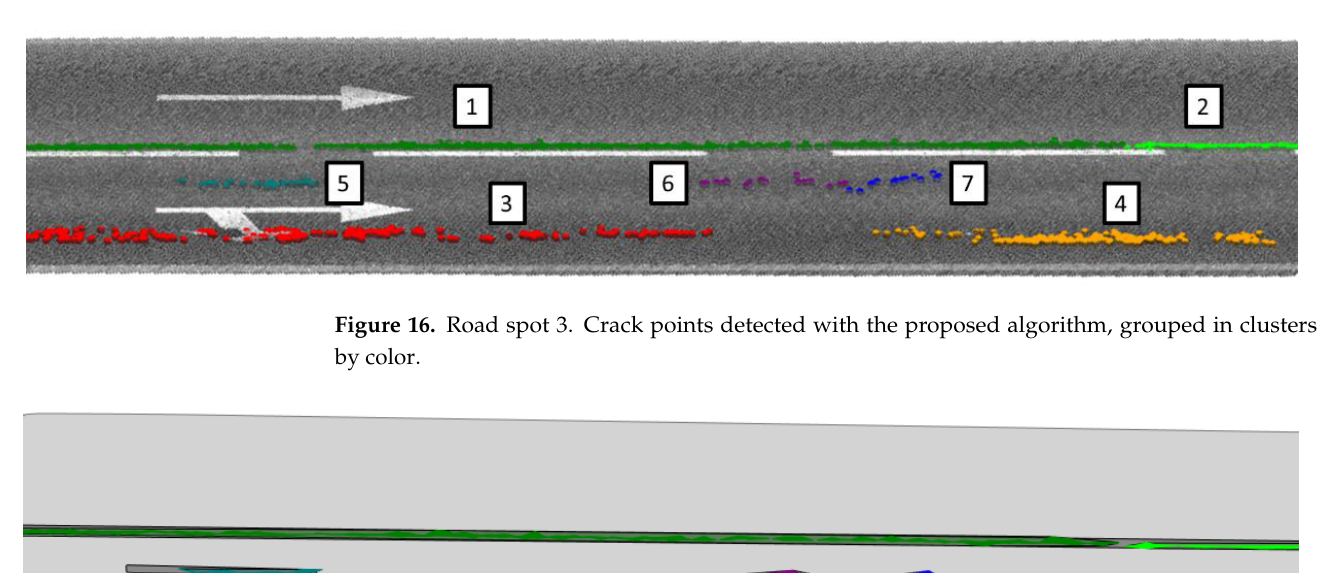
Figure 15. Road spot 3. Ladybug camera image with delimited cracked areas.